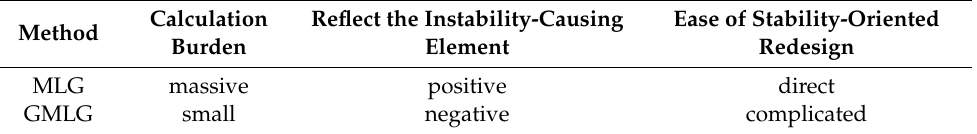
Table 1. Comparison of two